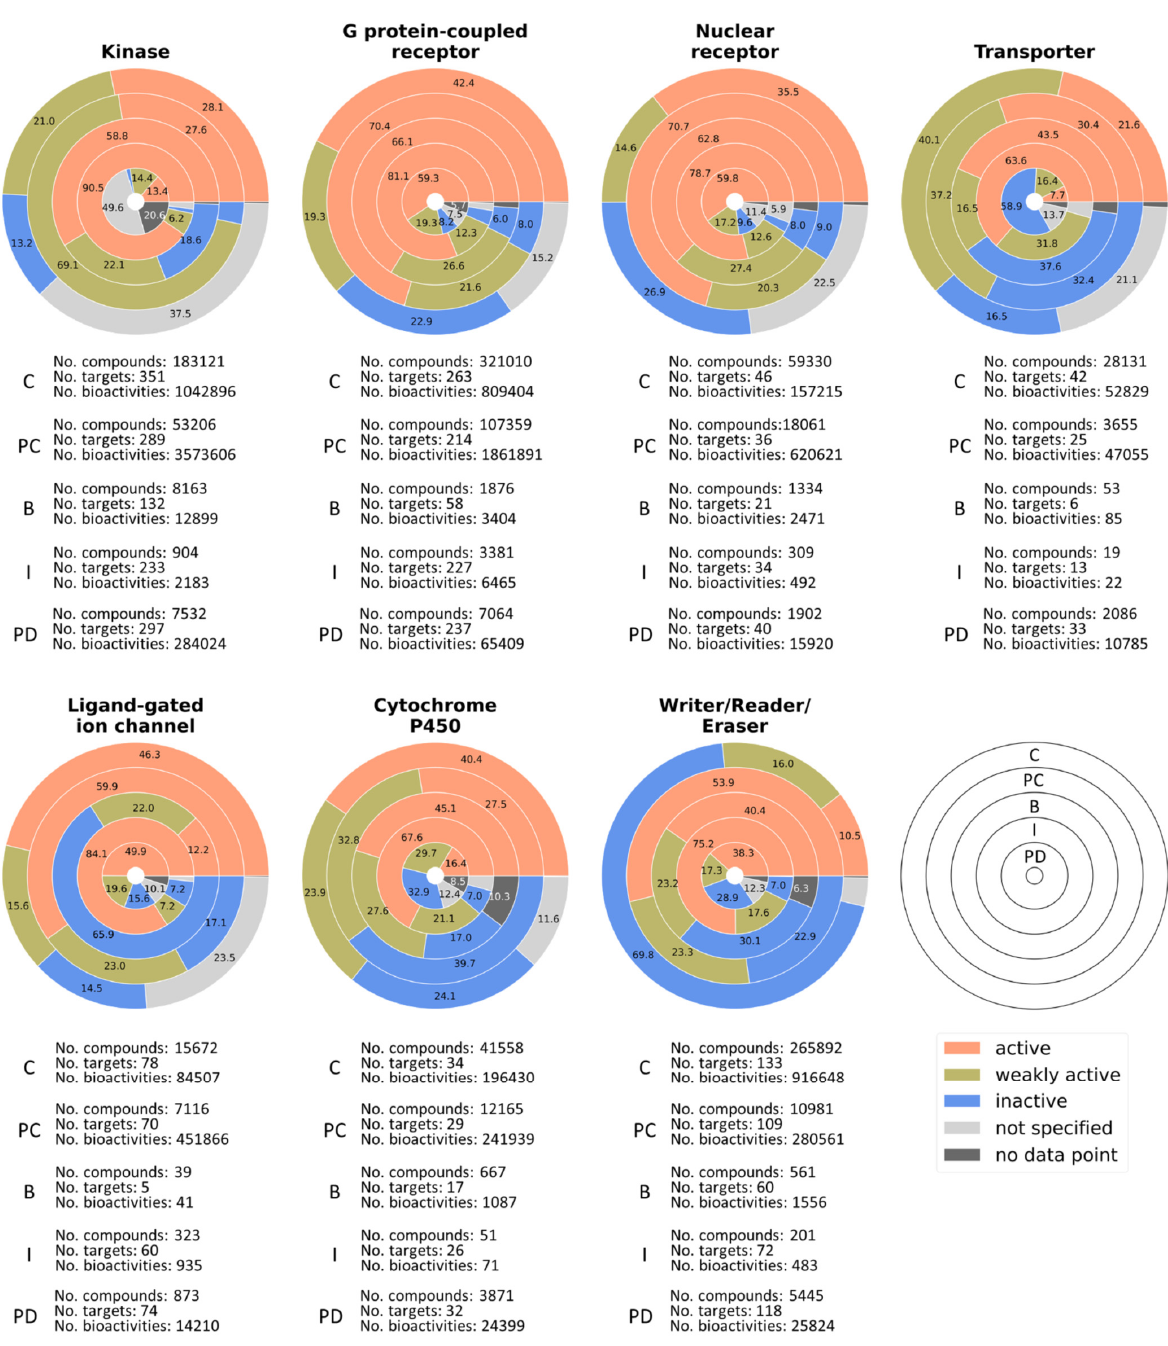
Figure 2. Percentage pie chart of the bioactivity labels for seven important target families and detailed numbers of associated targets, compounds, and bioactivities (C = ChEMBL, PC = PubChem, B = BindingDB, I = IUPHAR/BPS, and PD = Probes & Drugs). Each ring represents a database in the order shown in the legend. Percentages below 5% are not displayed.